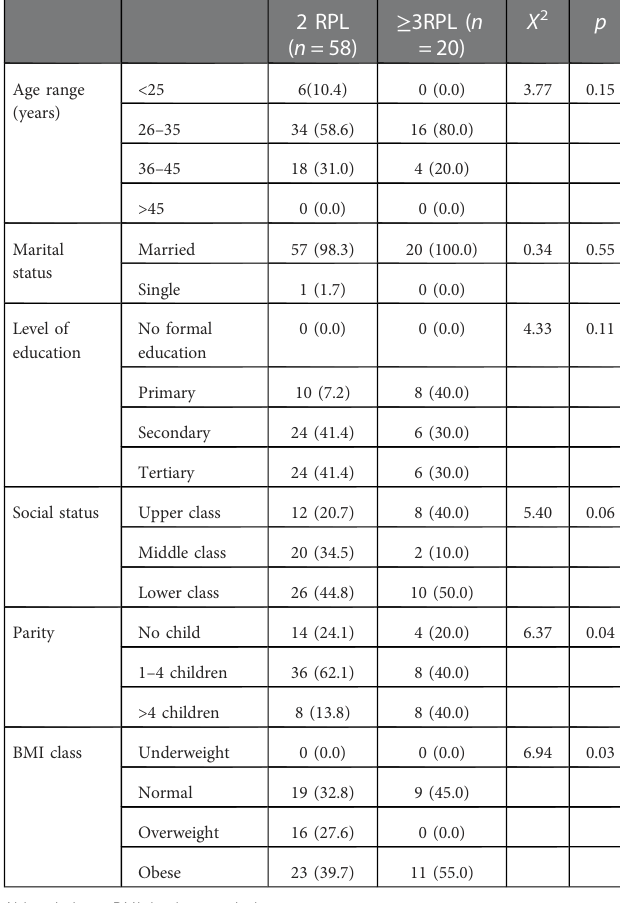
TABLE 3 Socio-demographic characteristics of participants with prior RPL according to ASRM (2 RPL) and wHO ( ≥ 3 RPL)